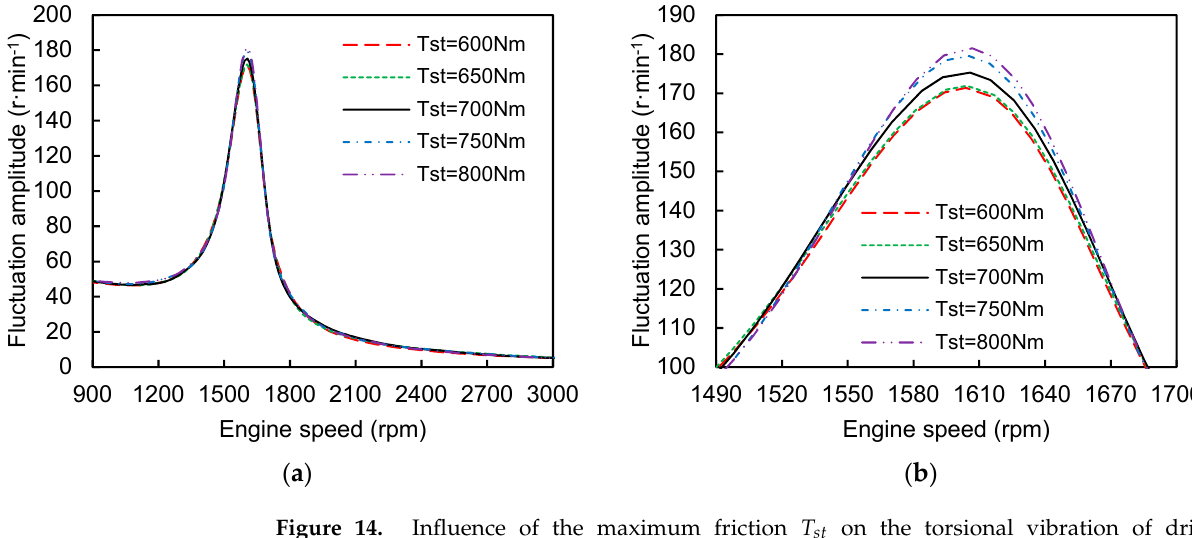
Figure 14. Influence of the maximum friction T st on the torsional vibration of driveline. ( a ) Second − order speed fluctuation of transmission; ( b ) partial enlarged view (baseline: the black solid curve).